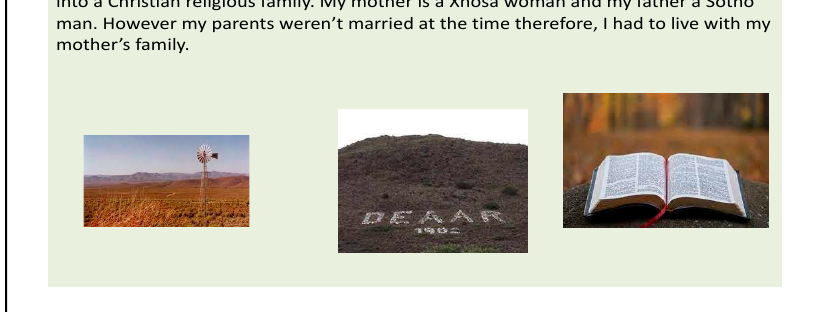
Figure 1. Lihile’s first life-phase timeline.